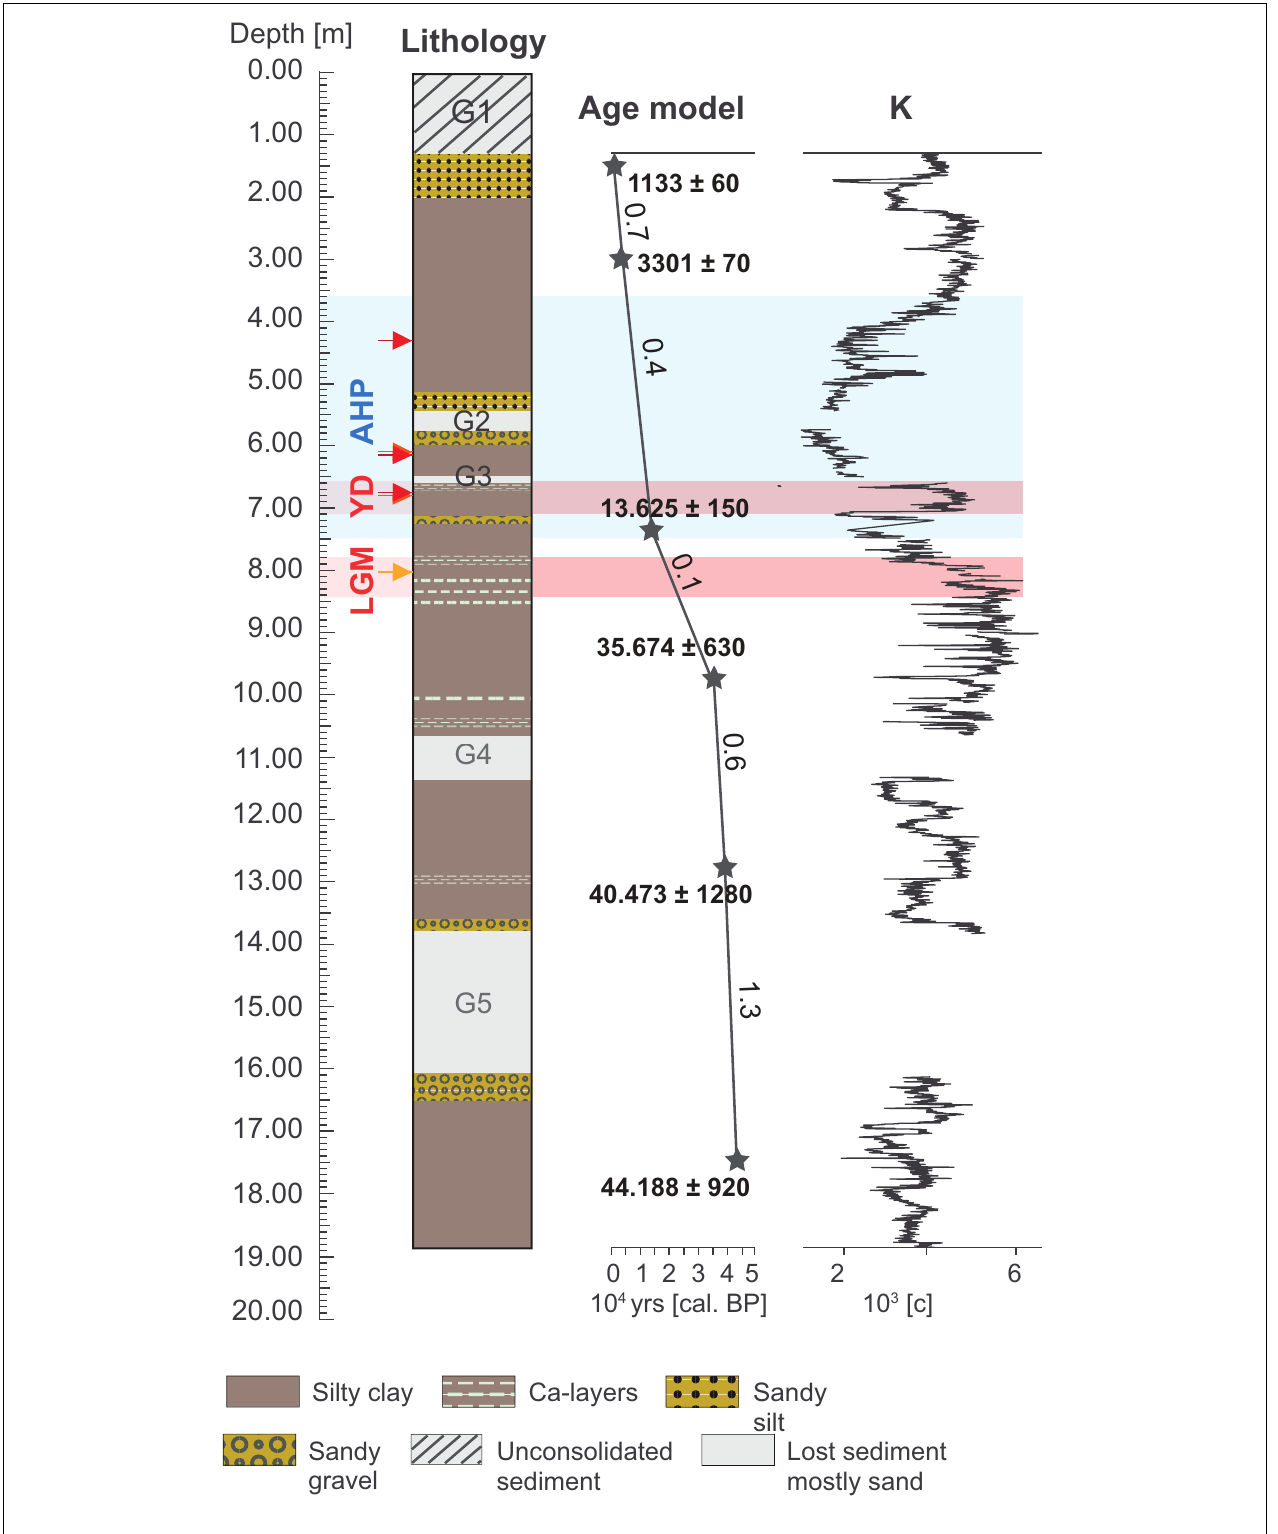
FIGURE 3 | Core lithology, age-depth model, and the Chew Bahir K record over the past ∼ 45 kyrs.